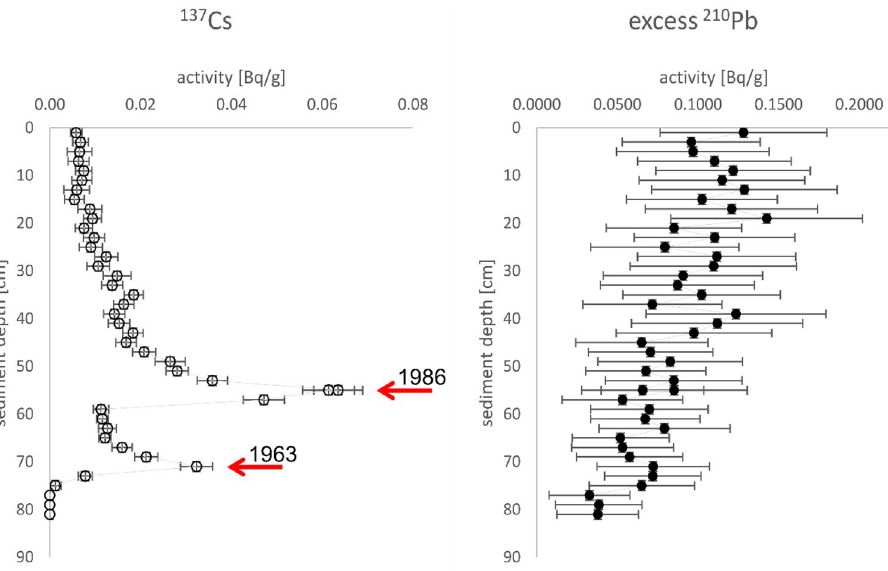
Figure 6. Downcore radioactivity of 137 Cs (left panel) and excess 210 Pb (right panel) in the sediment core from Lake Mikorzyńskie (MI). The prominent peaks in 137 Cs are assigned to 1986 (upper) and 1963 (lower). The average rate of sediment accumulation was calculated to be between < 0.7 cm/year for deeper sediments to > 1.1 cm/year for more recent sediments. The vertical error bars refer to analysed sediment sample thickness, while the horizontal bars depict 2-sigma uncertainty.